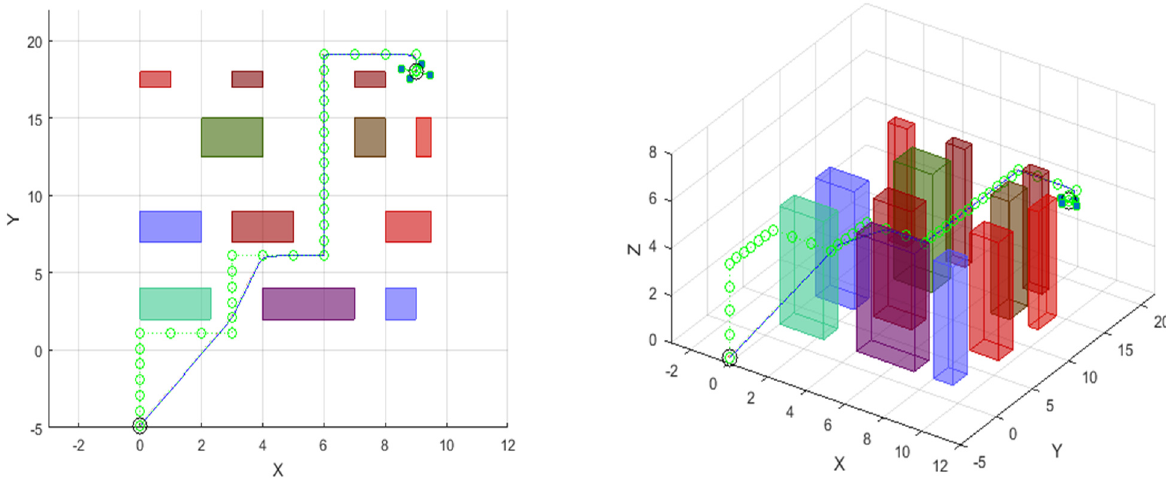
Figure 10. Quadrotor reaching the goal point after successful traversal (2D and 3D views).